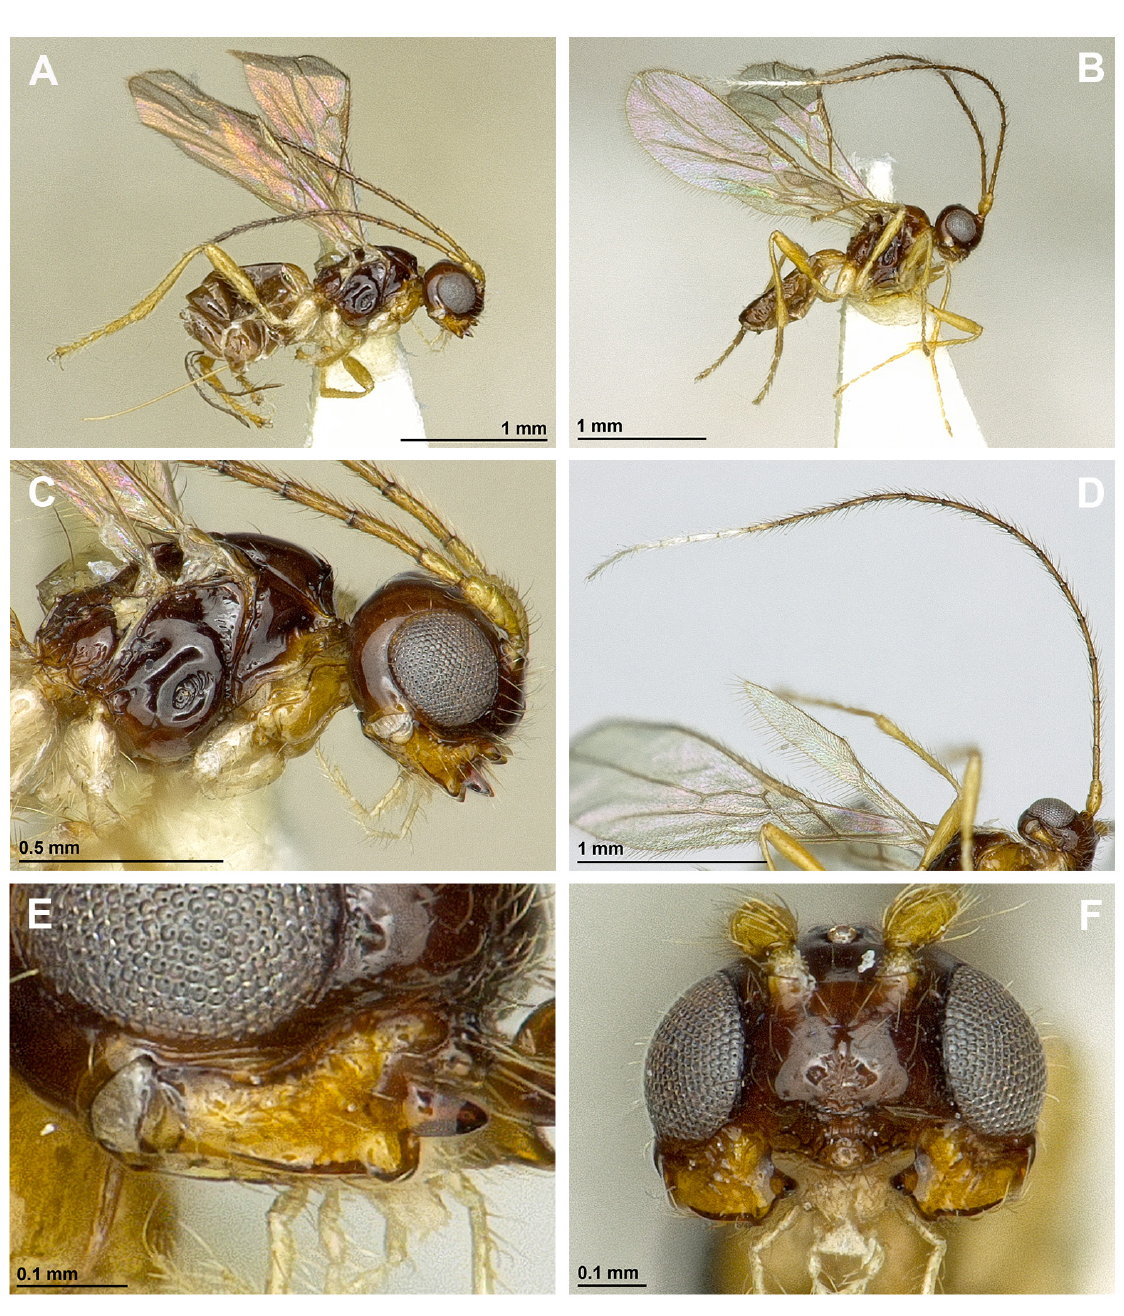
Fig. 9. Asobara citri (Fischer, 1963), A, C–F: ♀, holotype (NHMW); B: ♂ (NHMW). A–B . Habitus, lateral view. C . Head and mesosoma, lateral view. D . Antenna. E . Mandible. F . Head, front